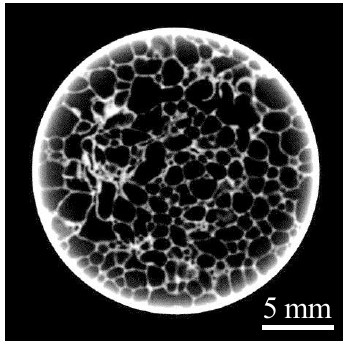
Figure 7. Typical cross-sectional X-ray CT image of Al foam-filled steel tube compression test specimen around the middle height of